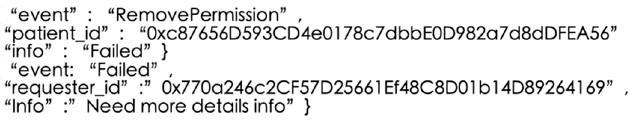
Figure 12. Result of give permission function.